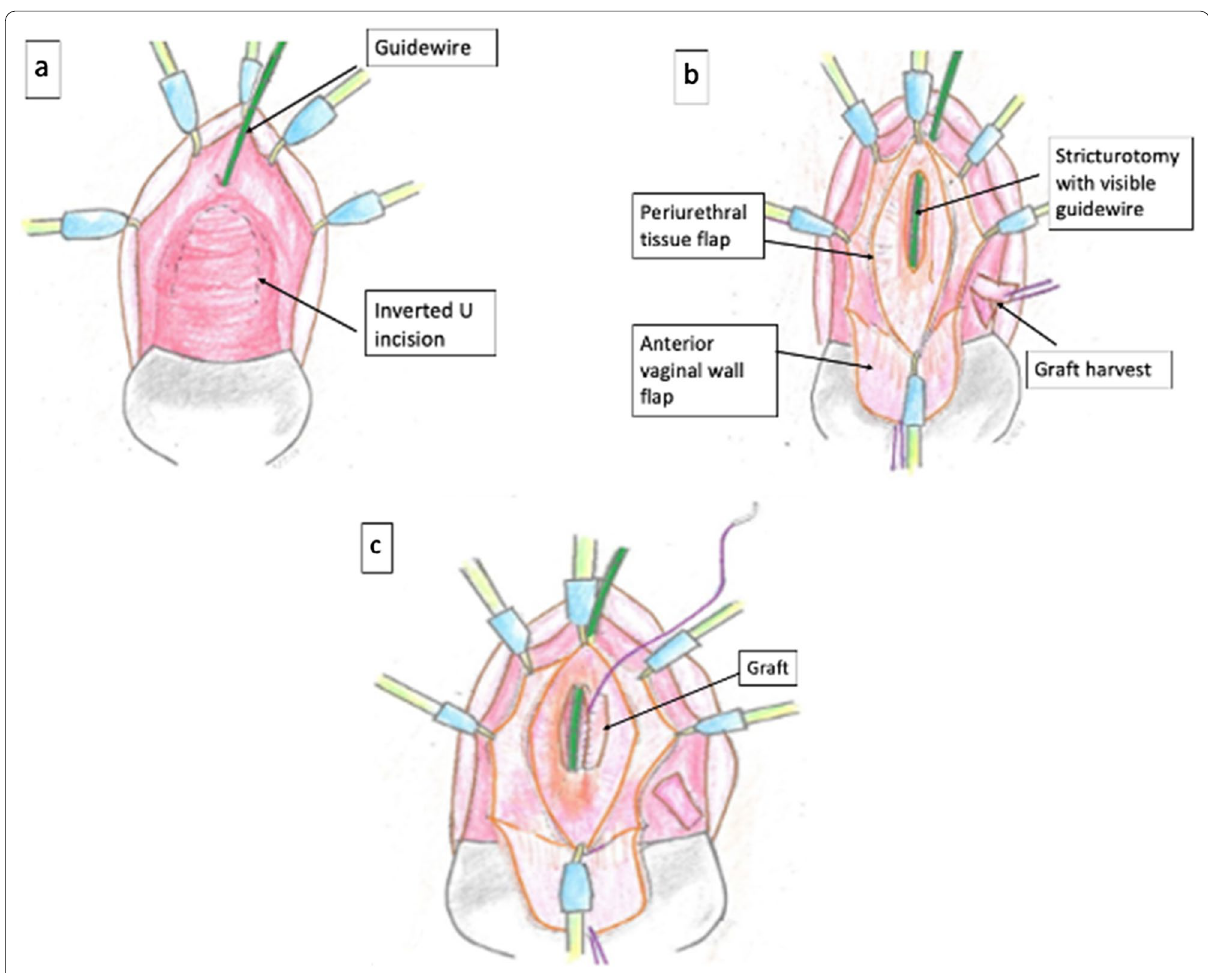
Fig. 2 Schematic depiction of technique a inverted U Incision, b incision of ventral strictured urethra and Graft harvest from posterolateral vaginal wall, c Graft placement and anastomosis [With permission from Goel H.K., Katiyar V., Gunavanthe V. (2021). Figure 15.1, 15,4, 15.5. Ventral (Posterior) Onlay Augmentation Urethroplasty for Female Urethral Stricture. In: Khattar N., Nayyar R., Panda A. (eds) Female Bladder Outlet Obstruction and Urethral Reconstruction. Springer, Singapore. https:// doi. org/ 10. 1007/ 978- 981- 15- 8521-0_